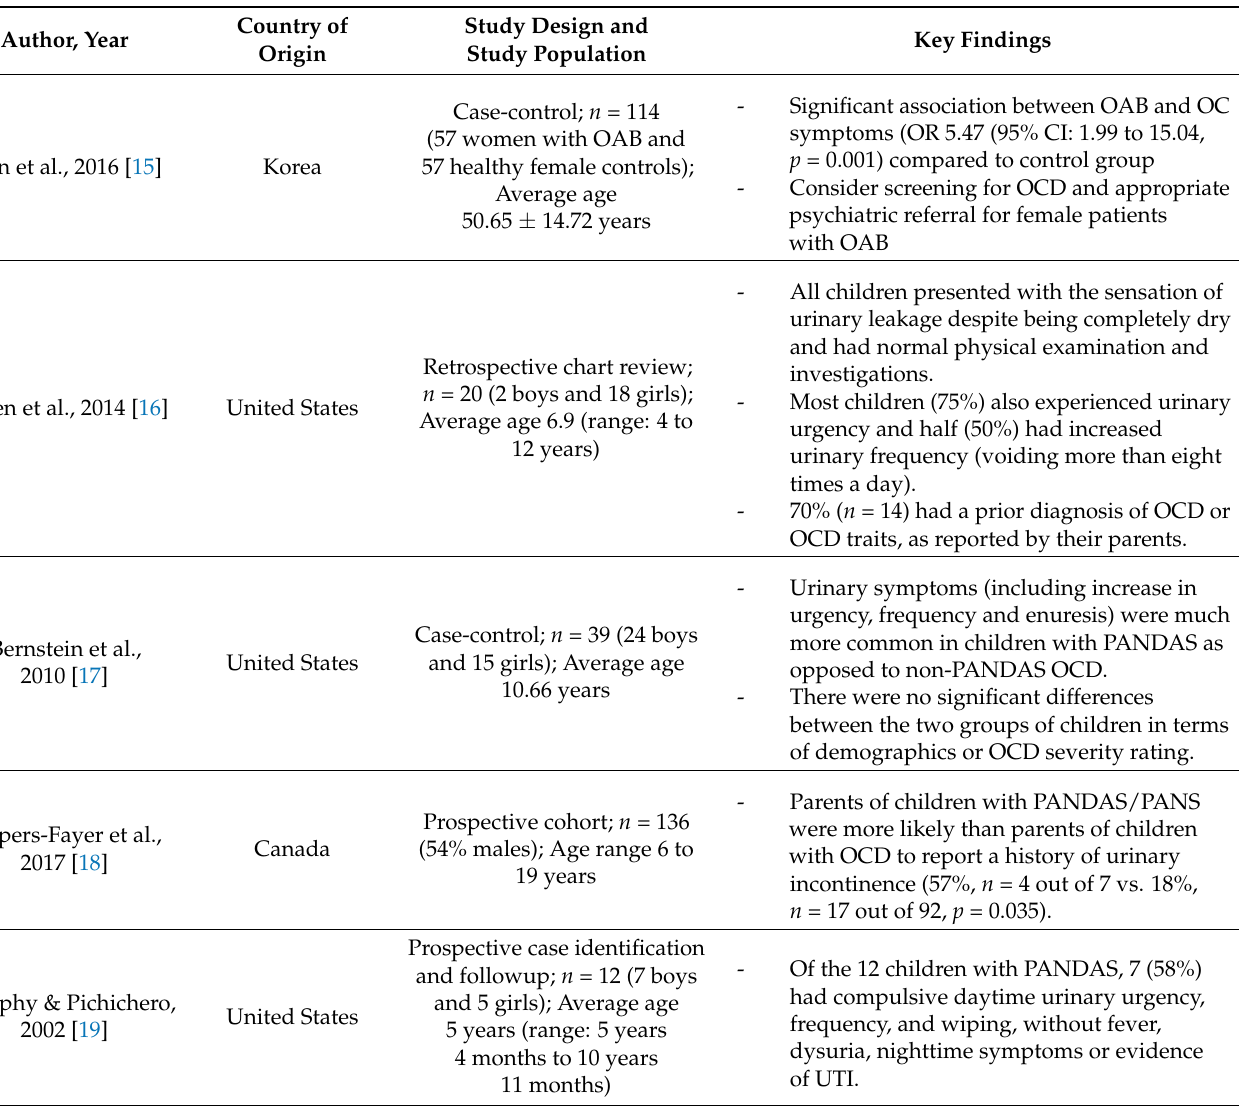
Table 1. Clinical studies reporting the occurrence of functional urinary disorders in patients with OC